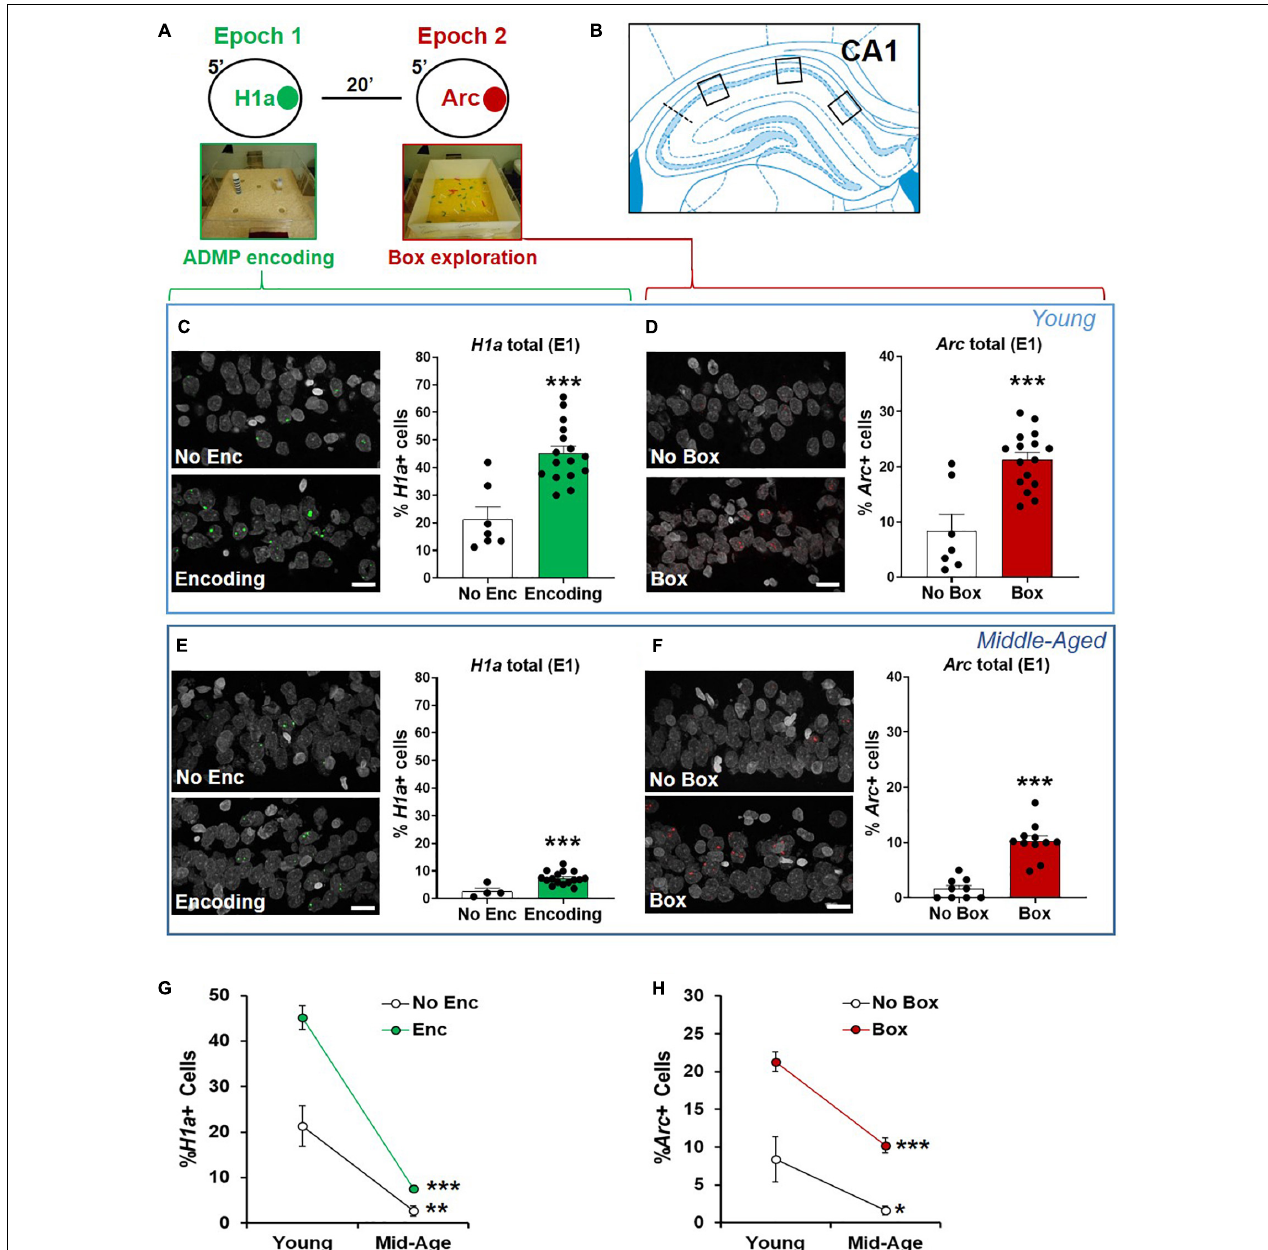
FIGURE 4 | The proportions of CA1 neurons activated by ADMP encoding and novelty are reduced in aging. (A) Rats could be exposed to ADMP encoding (3 pellets) during epoch 1 for 5 min and then to exploration of a novel box during epoch 2 for 5 min. The rats were randomly assigned to the following groups: home cage (HC) control, encoding in epoch 1, novelty in epoch 2, encoding followed by exploration in a novel box, or encoding followed by exploration in a familiar box. Neurons activated by epoch 1 were referred to as H1a +, while neurons activated by epoch 2 were referred to as Arc +. (B) Images were collected in 3 areas of CA1. (C) Example images and the percentage of H1a + CA1 neurons in young rats. A scale bar: 10 µ m. The young rats exposed to ADMP encoding (Enc) showed a higher percentage of H1a + neurons than the rats that did not receive ADMP encoding (No Enc, the HC rats, and the rats exposed only to novel box exploration). (D) Example images and the percentage of Arc + CA1 neurons in the young rats. A scale bar: 10 µ m. The young rats exploring a novel or familiar box (box) showed a higher percentage of Arc + neurons than the rats that did not (no box, the HC rats, and the rats exposed only to ADMP encoding). (E) Example images and the percentage of H1a + CA1 neurons in the middle-aged rats. A scale bar: 10 µ m. The middle-aged rats exposed to ADMP encoding (Enc) showed a higher percentage of H1a + neurons than the rats that did not receive encoding (No Enc, the HC rats, and the rats exposed only to novel box exploration). (F) Example images and the percentage of Arc + CA1 neurons in the middle-aged rats. A scale bar: 10 µ m. The middle-aged rats exploring a box showed a higher percentage of Arc + neurons than the rats that did not (no box). (G) The percentage of H1a + CA1 neurons decreased with aging in control condition (No Enc, the HC rats) or after ADMP encoding (Enc). (H) The percentage of Arc + CA1 neurons decreased with aging in control condition (no box, the HC rats, and the rats exposed only to ADMP encoding) or after exploration in a box (box). All data are presented as mean ± SEM. * p < 0.05, ** p < 0.01, and *** p <